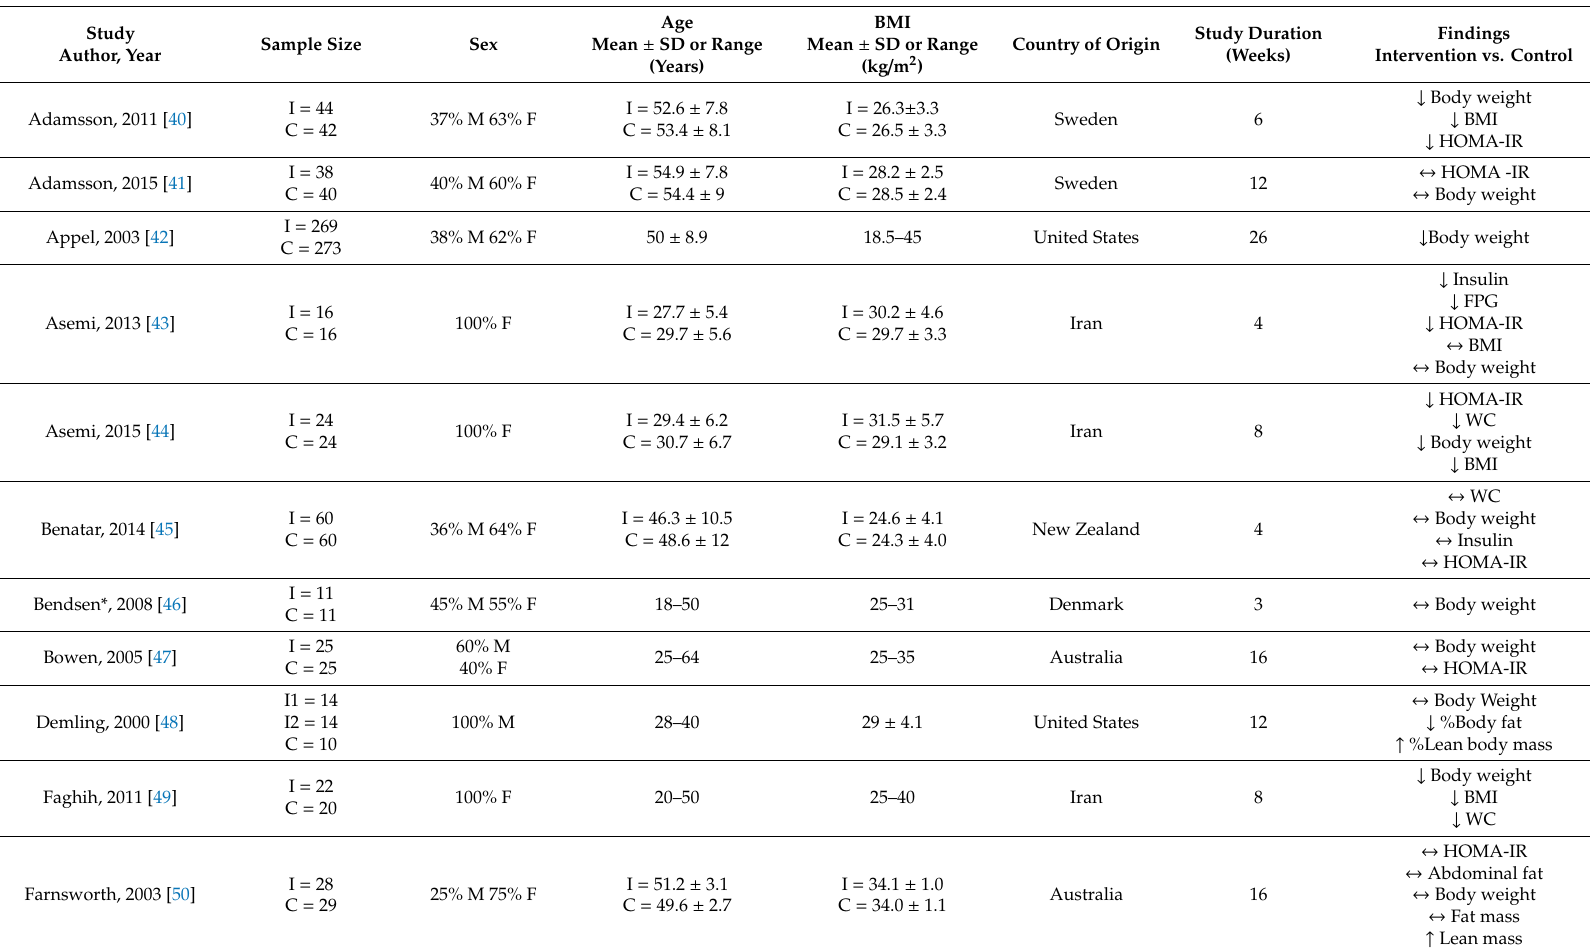
Table 1. Randomized controlled trials of dairy intake included in the